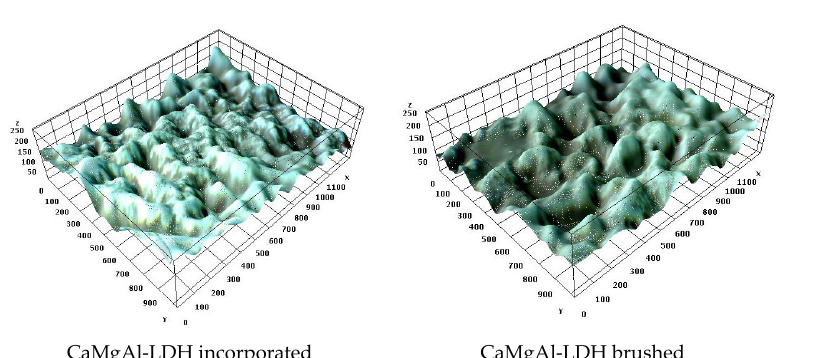
Figure 6. The images resulted from roughness processing ImageJ software. The values of the most representative roughness parameters recorded for the model stone samples are presented in Table 6. From the measurements, R-values on the whole surface give roughness values according to the ISO 4287/2000 standard [73]. The main parameters that had to be analyzed were: Ra: Arithmetical mean deviation; Rq: Root mean square deviation; Rku: Kurtosis of the assessed profile; Rsk: Skewness of the assessed pro- file; all these are given in calibrated units [74]. Their values are shown in Table 8 for all types of samples: control, brushed, and incorporated ones. Table 8. Roughness parameters and pore surface area for the treated and control model samples. Sample